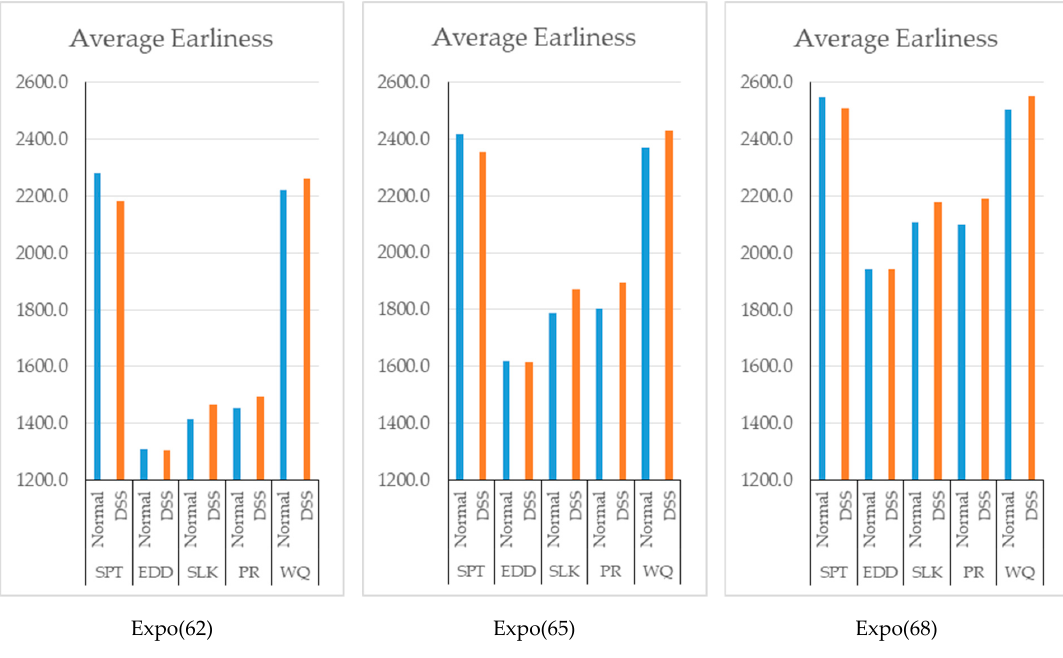
Figure 10. Average Earliness.